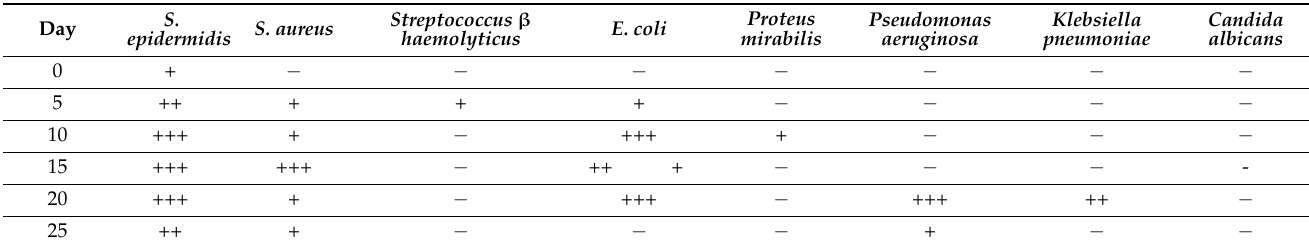
Table 4. Identification of pathogens grown from the wound treated with the 1% nanosilver ointment. Day